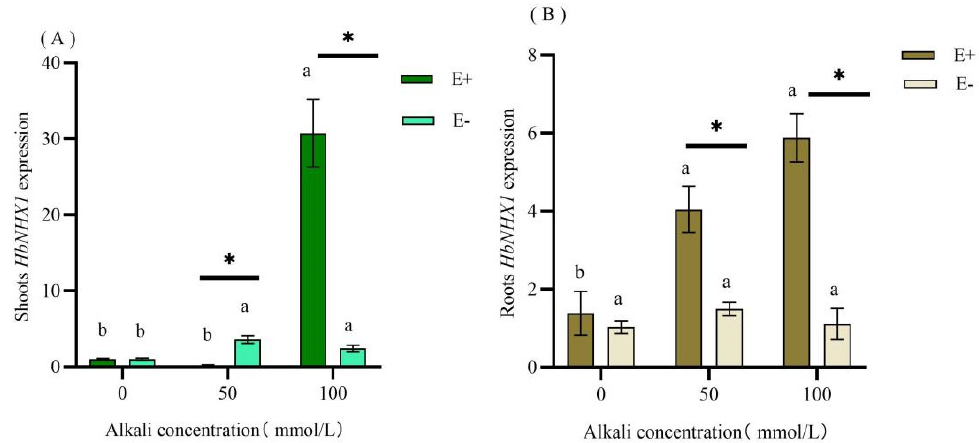
Figure 6. Effect of alkali stress on HbNHX1 gene expression levels in E+, E − shoots ( A ) and roots ( B ) of H. bogdanii. Note: Among different groups, when comparing the same E+ or E − plant, different lowercase letters of the column mark indicate a significant difference ( p < 0.05); in the same group E+ compared with E − , * indicates a signi fi cant di ff erence ( p < 0.05).